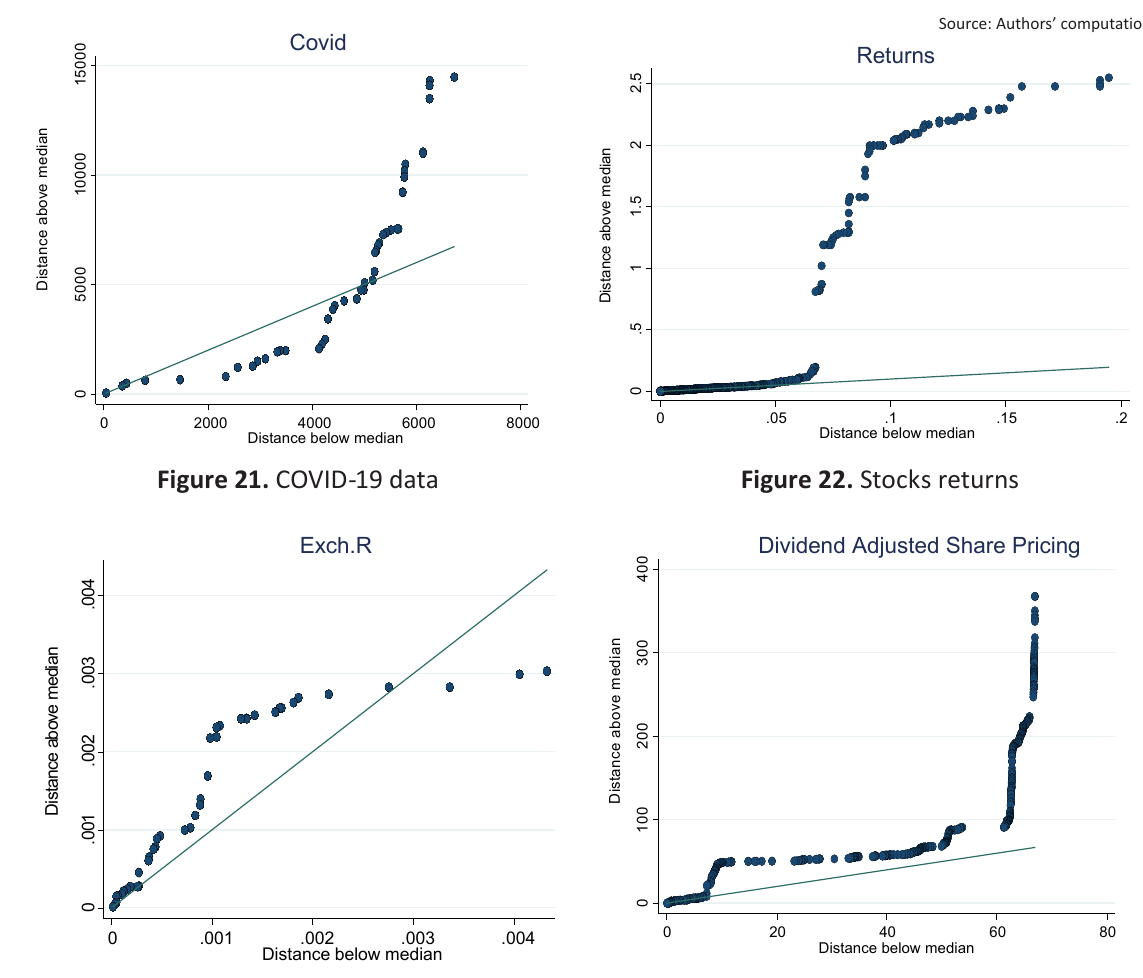
Figure 23. Exchange rate Figure 24. Dividend adjusted share